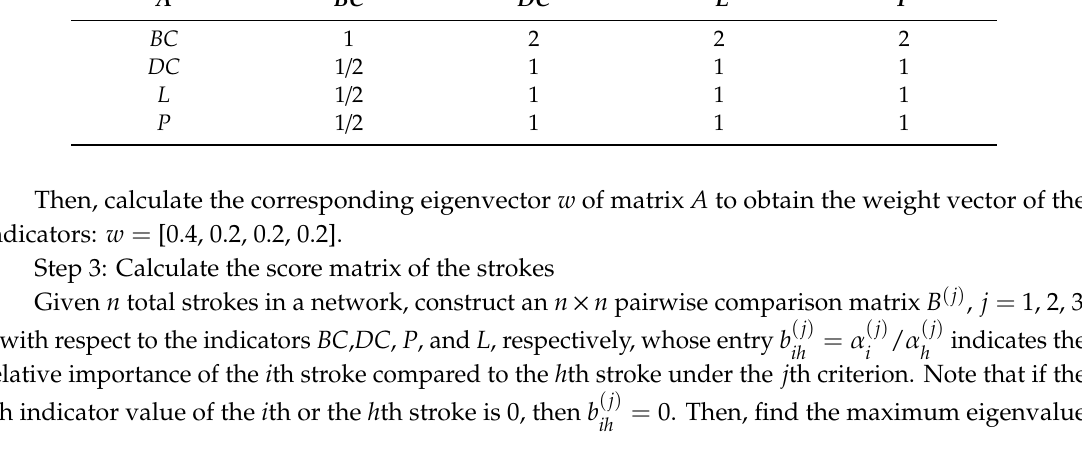
Table 5. Comparison matrix of the indicators.